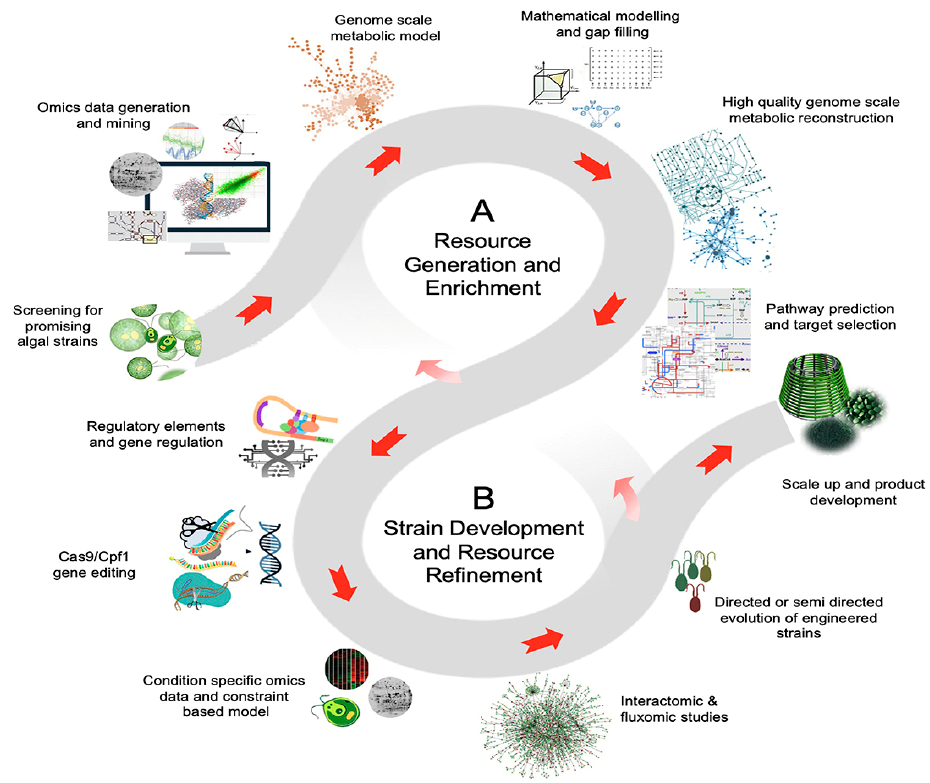
Figure 6. ( A ) Creation and enrichment of resources: High-quality curated data can be produced through high-throughput technologies, intensive bioinformatic analysis and computation, and sub- stantial scientific interest in microalgae. ( B ) The development of microalgae strains can be aided by the application of cutting-edge technologies such as genome editing and high-throughput variant selection, as well as findings from metabolic models. The metabolic flux changes in mutants fre- quently imply that an organism evolved to optimise flux reconfiguration. The increased production of desired products may be the goal of the shift in the flux balance. Additionally, the knowledge gained through refined modelling and genomic-editing studies opens up new research opportunities [50], open